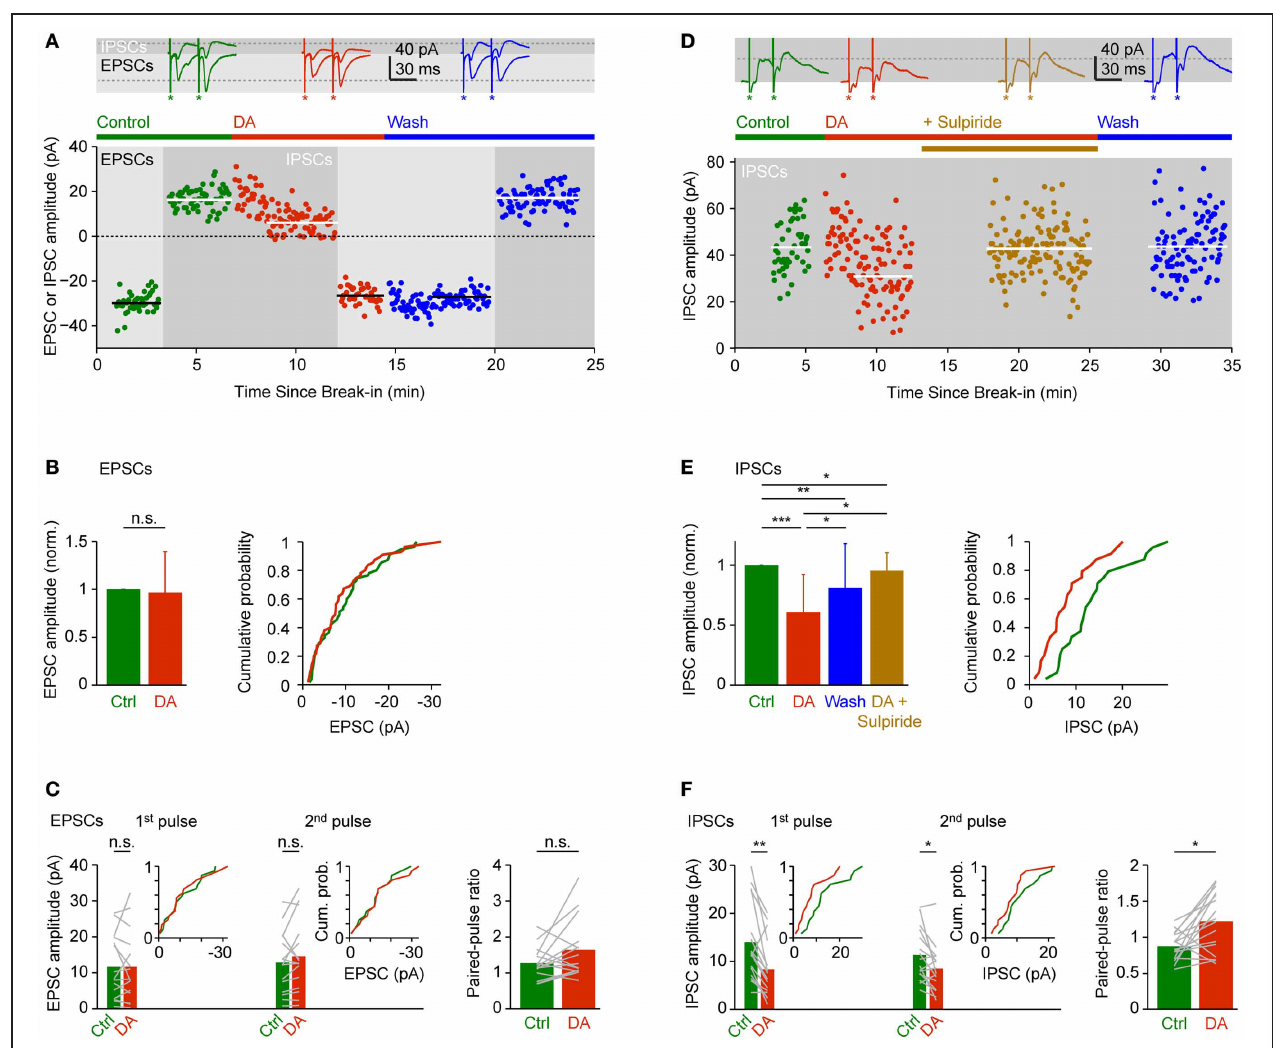
FIGURE 5 | Effects of DA on EPSCs and IPSCs evoked by electrical stimulation of the olfactory tract. (A) EPSCs and IPSCs in a Dp neuron evoked by electrical stimulation before, during and after bath-application of DA (50 µ M). EPSCs were recorded at a holding potential of − 70mV during the periods indicated by light gray shading; IPSCs were recorded at 0mV during periods indicated by dark gray shading. Horizontal lines indicate mean EPSC or IPSC amplitudes. Top: examples of EPSCs and IPSCs evoked by pairs of stimuli before (green), during (red) and after (blue) exposure to DA. Asterisks indicate stimulus artifacts (30ms inter-stimulus interval). Dashed lines indicate amplitude of EPSC and IPSC evoked by the first pulse before DA. In the scatter plot, current amplitude was quantified in response to the first pulse only. (B) Mean normalized EPSC amplitude ( ± SD) before and during application of DA (left; n = 55 neurons in 28 fish, 53/55 neurons vglut2a-GFP-positive) and cumulative probability distribution of EPSC amplitudes before (green) and during (red) exposure to DA. If currents were evoked by pairs of pulses, only the response amplitude evoked by the first pulse was quantified. (C) Mean EPSC amplitude evoked by the first and